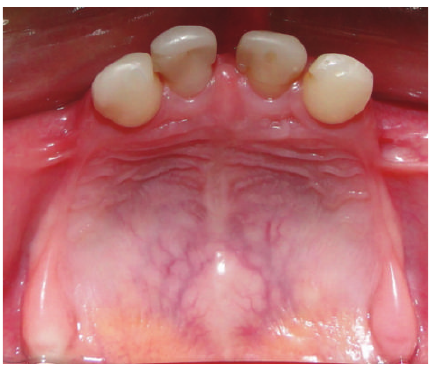
Figure 2: Occlusal view of the maxilla.